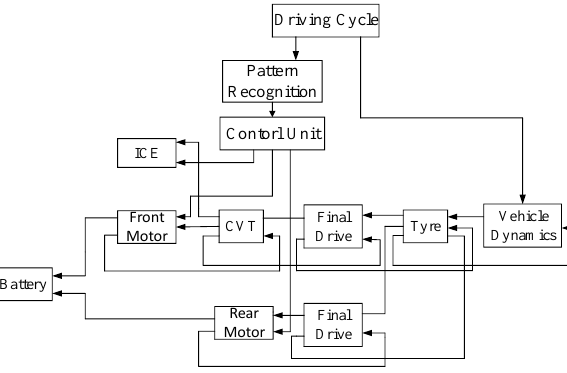
Figure 12. Diagram of backward simulation model.